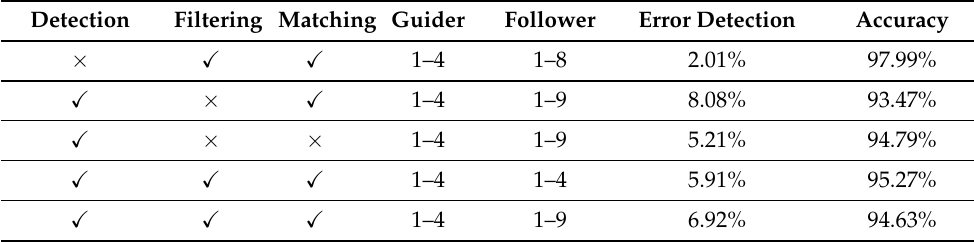
Table 7. Ablation